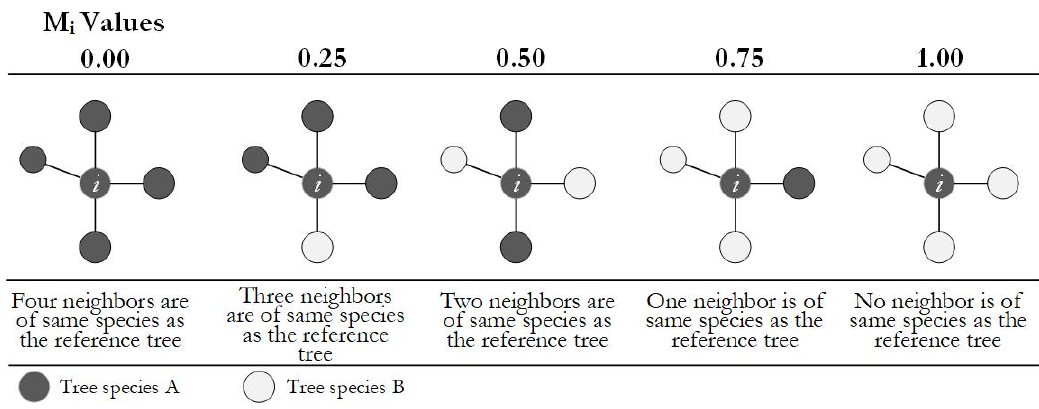
Figure 4. Principle of the mingling.